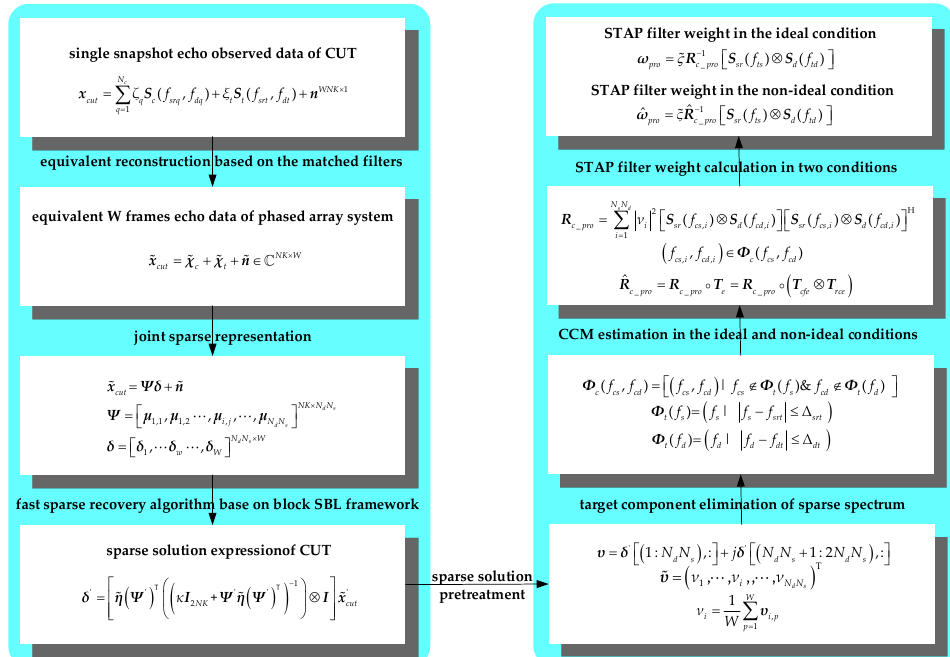
Figure 5. Flowchart of the proposed robust space-time joint sparse processing scheme.